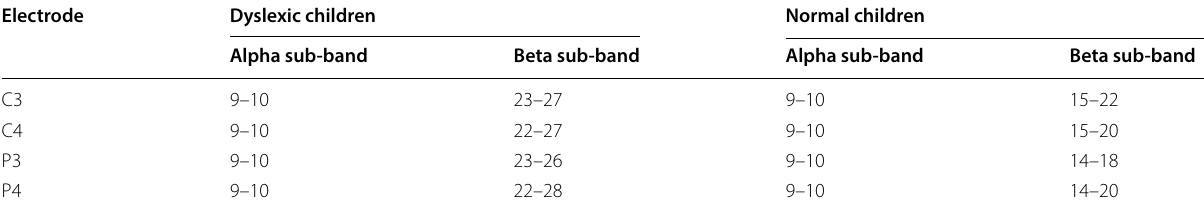
Table 3 Frequency range (Hz) of EEG for writing activities [42] Electrode Dyslexic